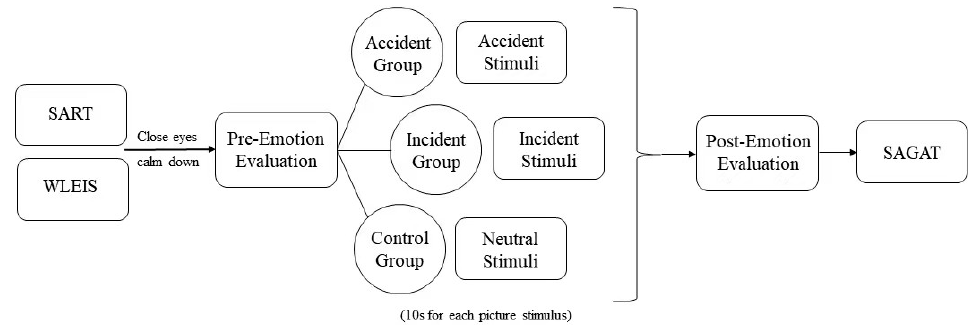
Figure 4. Procedure list .